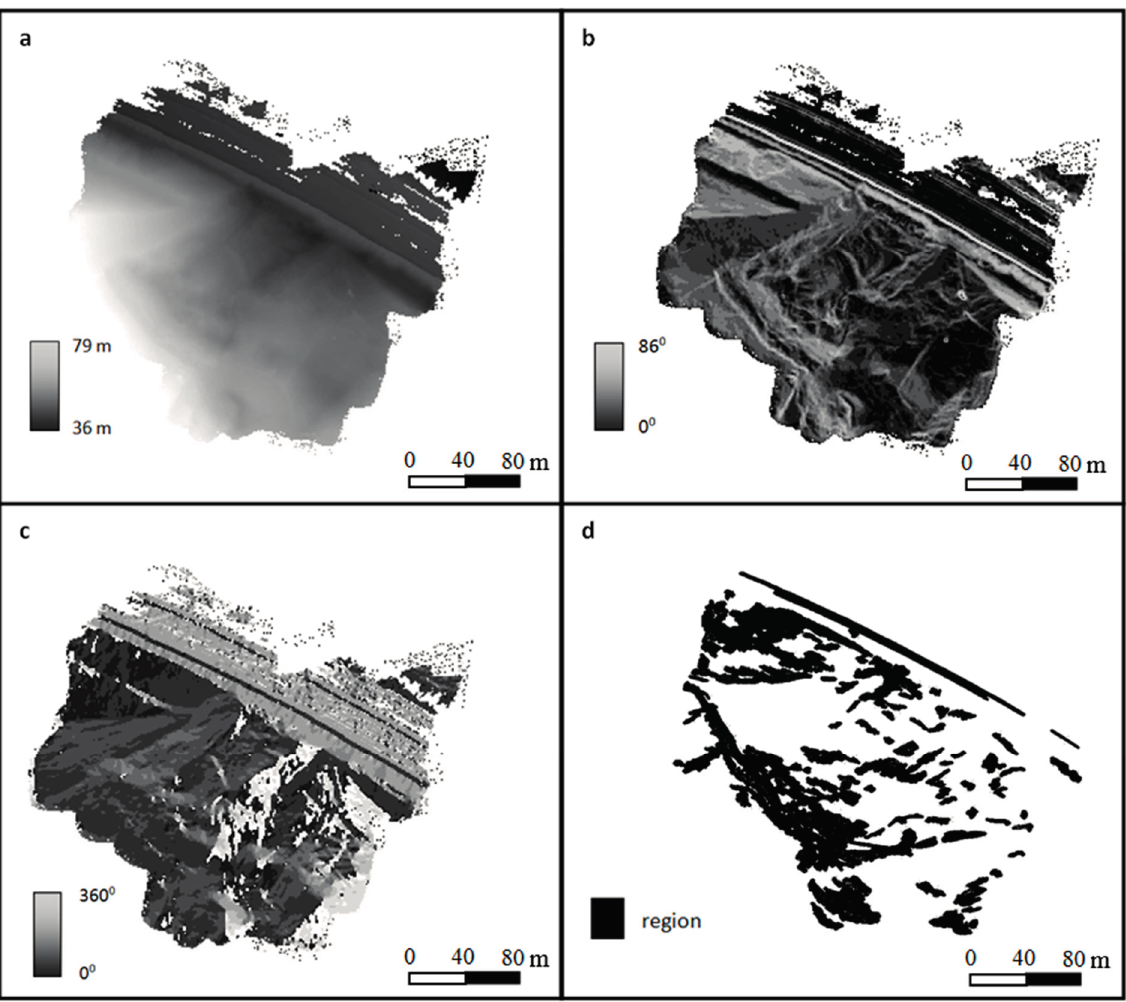
Figure 7. ( a ) Elevation raster; ( b ) slope raster; ( c ) aspect raster; and ( d ) Maximally stable external regions